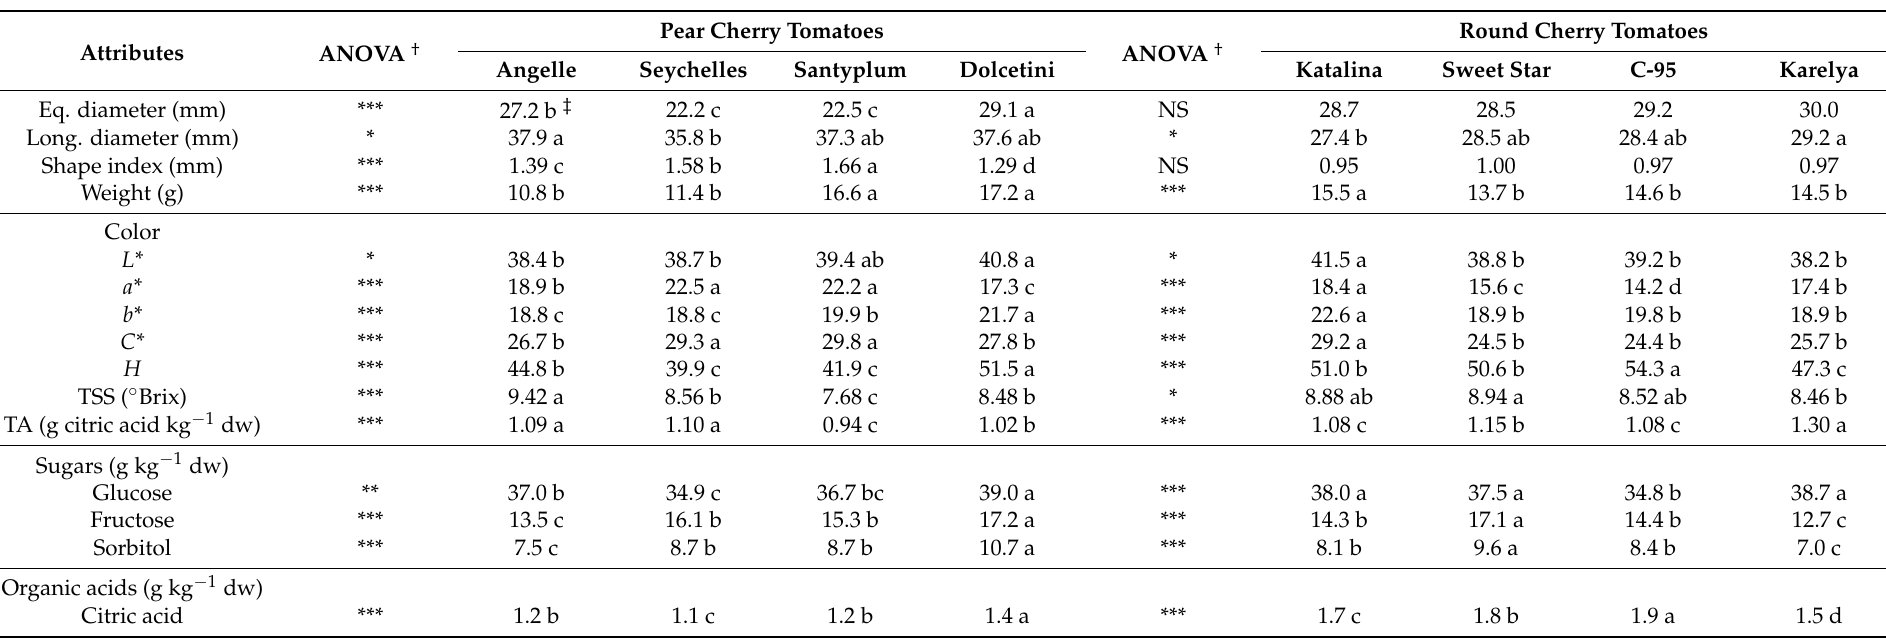
Table 1. Morphology, color, total soluble solids (TSS), titratable acidity (TA), sugars, and organic acids in cherry tomatoes as affected by cultivar for pear and round fruits.